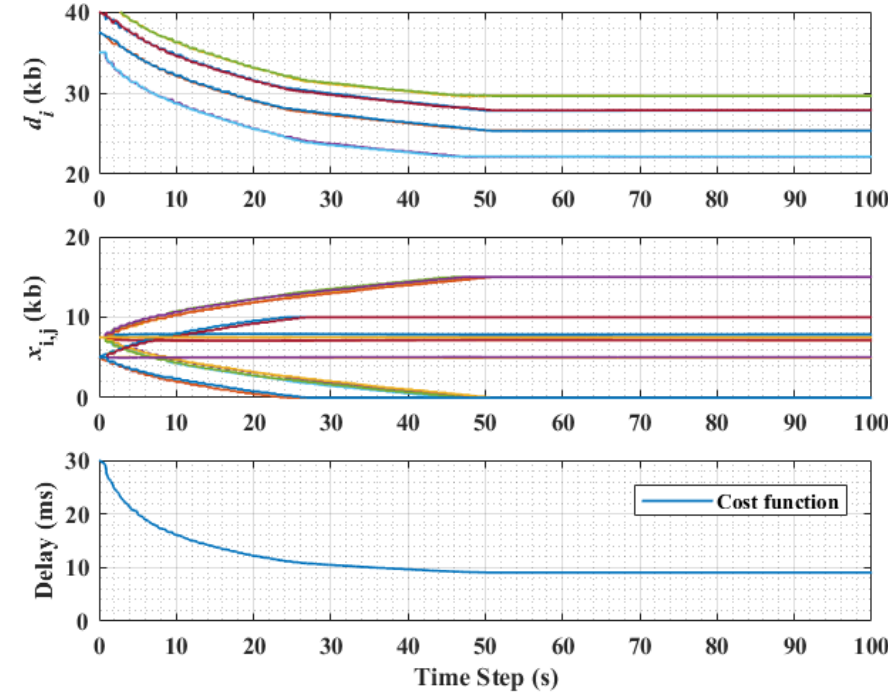
Figure 4. Half mesh topology: ( Topmost plot ) Convergence of the transmitted messages. ( Middle plot ) Convergence of the communication links. ( Lower plot ) The network delay